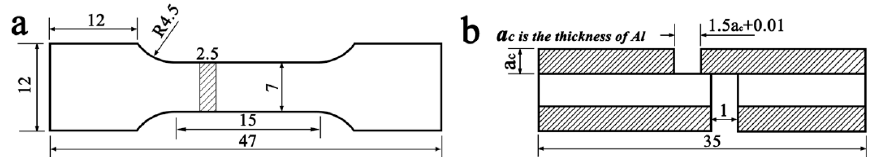
Figure 2. The schematic draw of specimens for ( a ) tensile and ( b ) shear test. (Unit: mm).